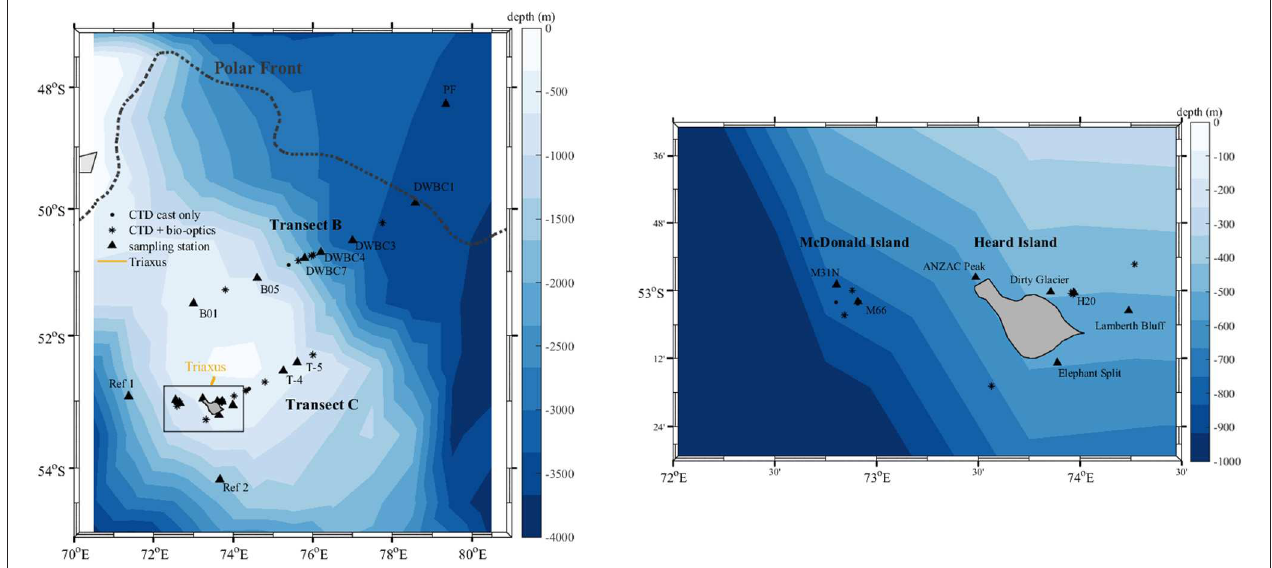
FIGURE 2 | Geographic location of sampling stations. Colors indicate the